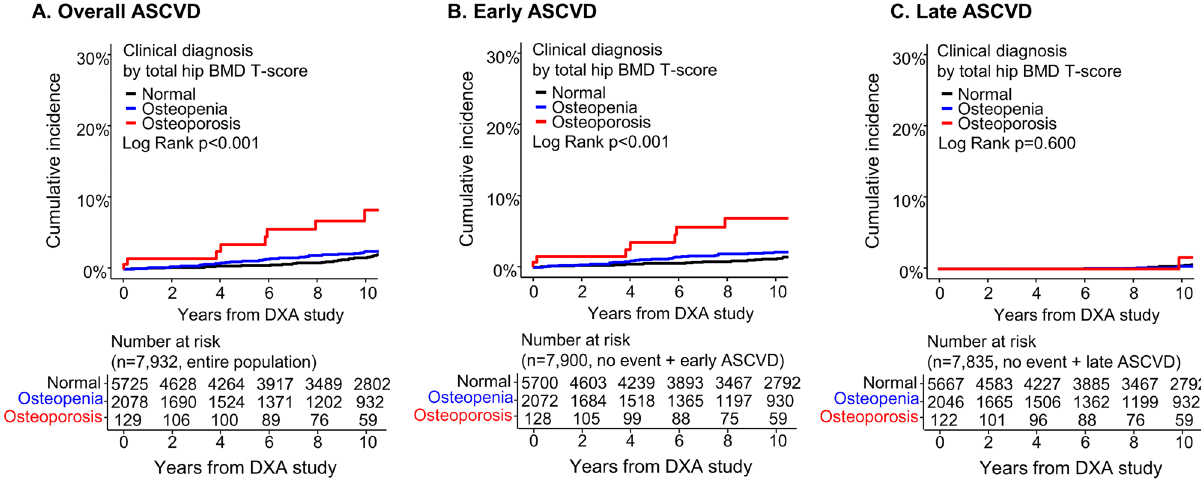
Figure 2. Cumulative incidence of ASCVD according to the clinical diagnosis. The figure represents cumulative incidence of overall ( A ), early ( B ), and late ( C ) ASCVD according to the clinical diagnosis of normal BMD, osteopenia, and osteoporosis. Significant differences were observed for overall and early ASCVD, but not for late ASCVD. ASCVD atherosclerotic cardiovascular disease, BMD bone mineral density, DXA dual-energy X-ray absorptiometry.